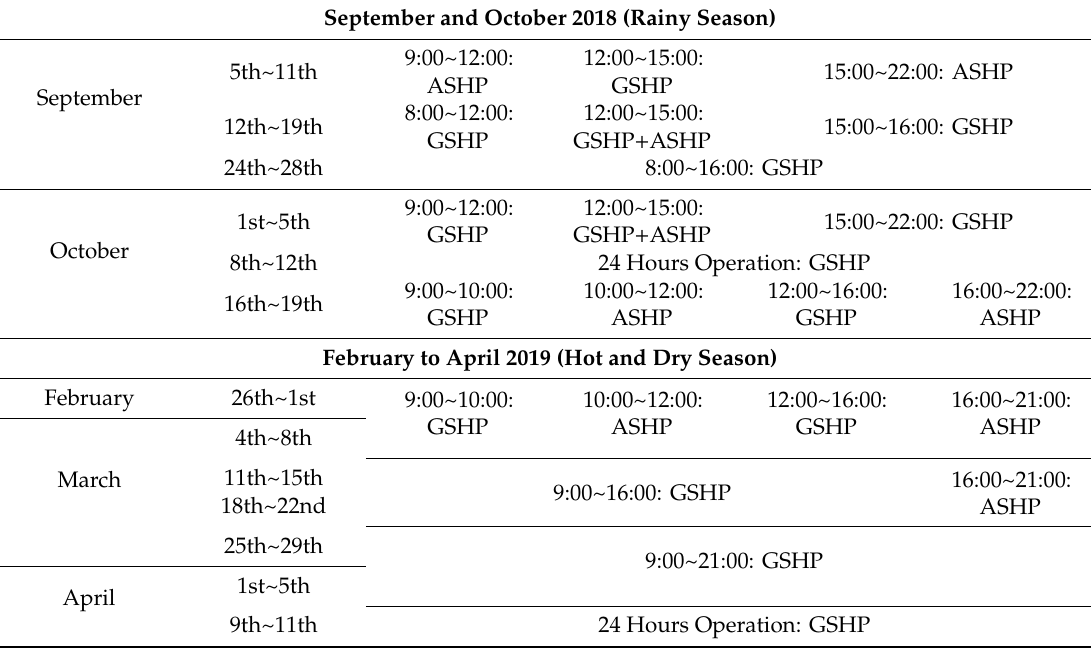
Table 2. Operational experimental